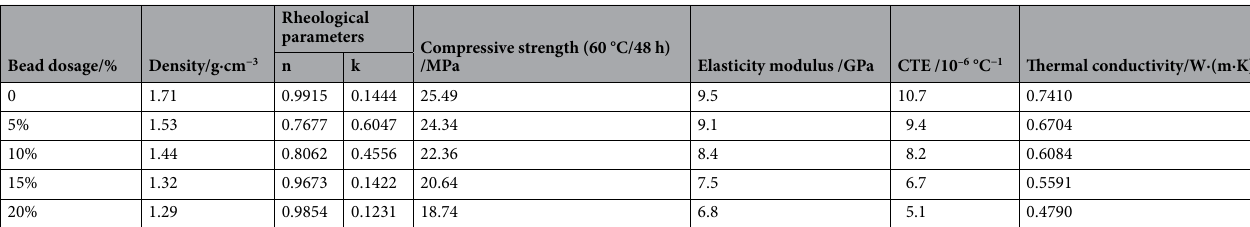
Table 2. Effect of hollow glass beads on cement slurry and hardened cement performance. The percentage of bead is the mass percentage of cement